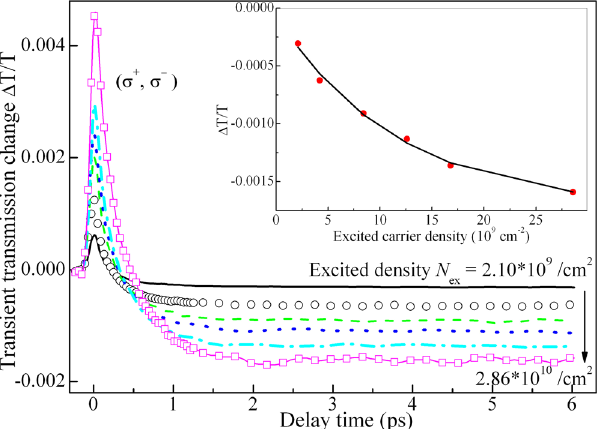
Figure 3. Ultrafast dynamics with cross-circularly polarized pump and probe as a function of excited hole density. In inset, the amplitude (filled circles) of transient differential transmission at ~3 ps versus excited hole density is plotted. Solid line is the best fitting to scattered filled circles with Eq. (2) described in